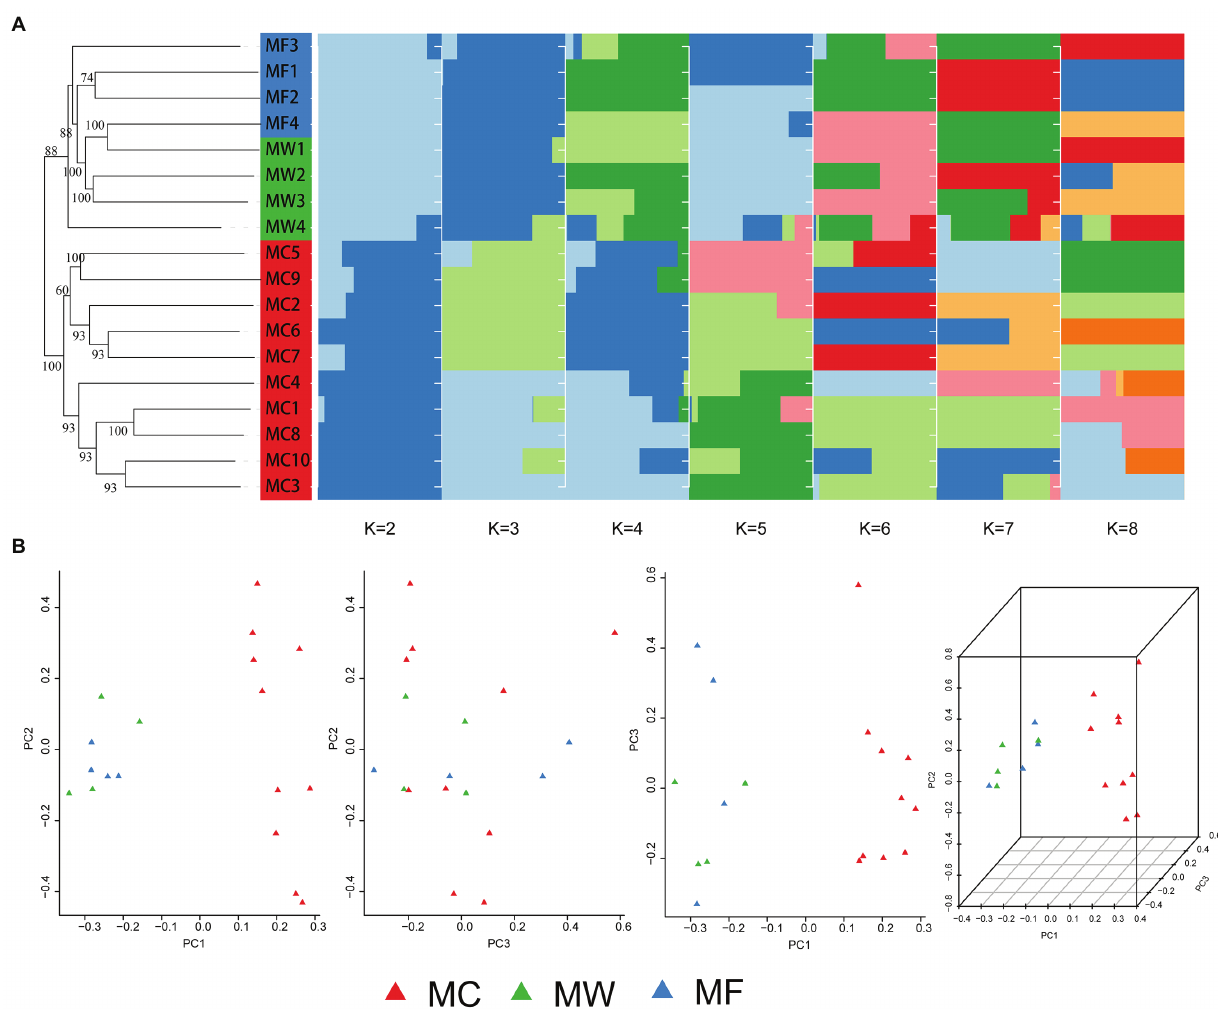
FIGURE 2 | Population genetic structure among the captive population (MC), the free-ranging population (MF), and the wild population of reintroduced Père David’s deer. (A) Neighbor-joining (NJ) phylogenetic tree (left) and subgroups represented by the STRUCTURE analysis ( K = 2, 3, 4, 5, 6, 7, and 8 shown; right). (B) Principle Component Analysis (PCA)